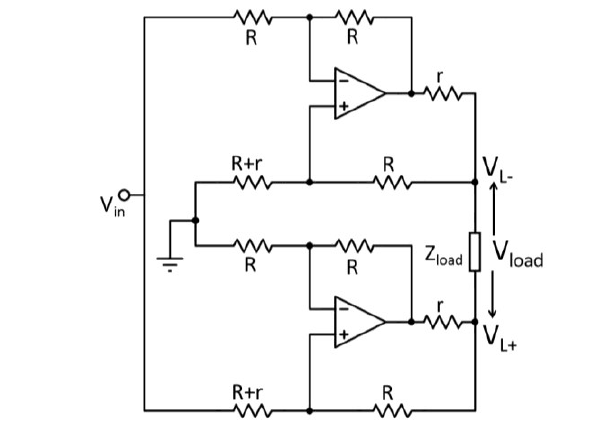
Fig.5: Mirrored Enhanced Howland Current Source (MEHCS).